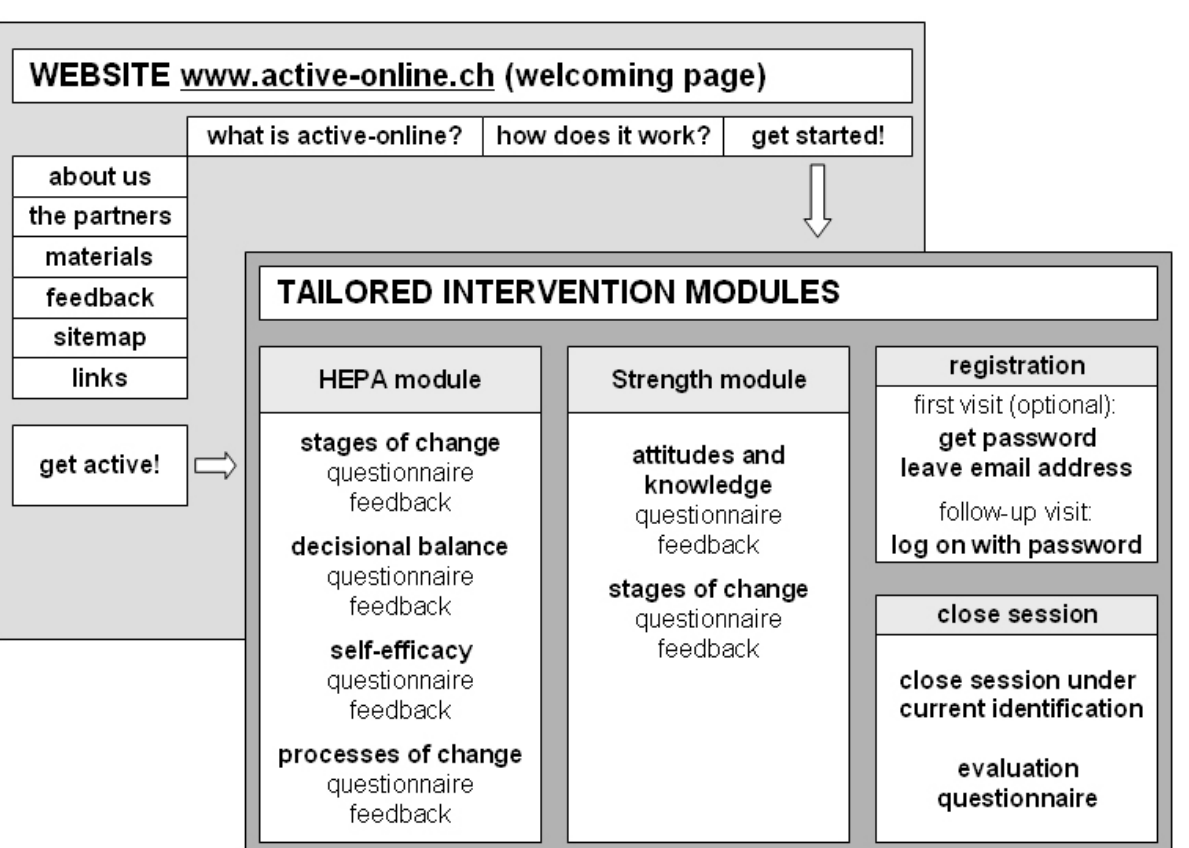
Figure 2. Structure of Active-online and the tailored intervention